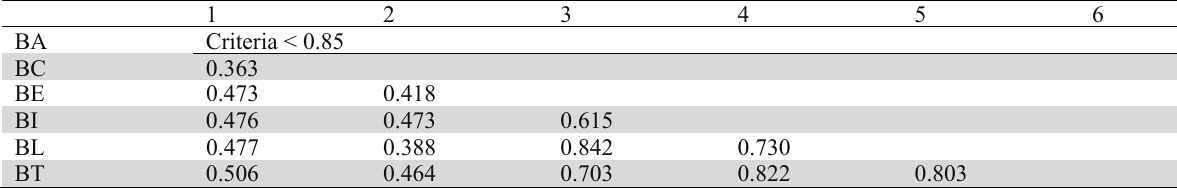
Discriminant validity (heterotrait-monotrait